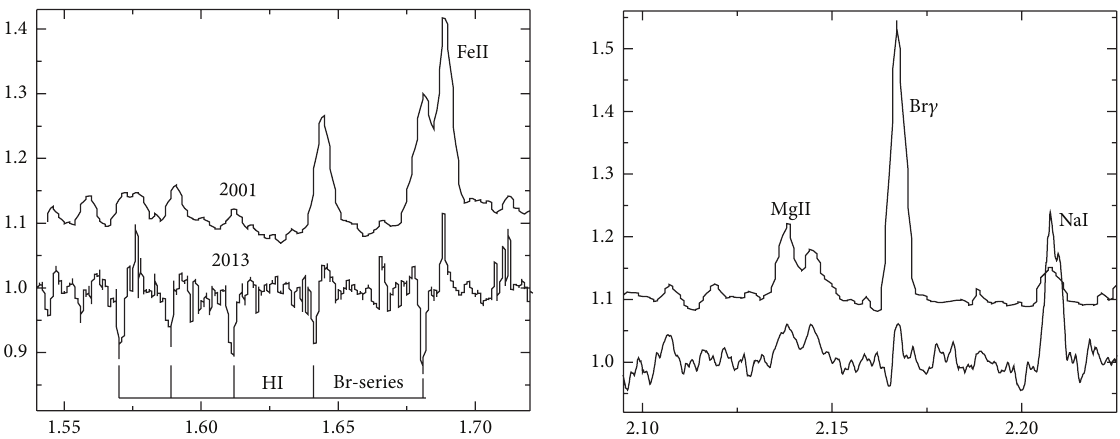
Figure 5: Parts of the Lick near-IR spectrum of MWC 930 obtained on 2013 July 21. The intensity is normalized to the underlying continuum, and the wavelengths are in 𝜇 m. The spectrum from 2001 is shifted up by 0.2 continuum intensity.